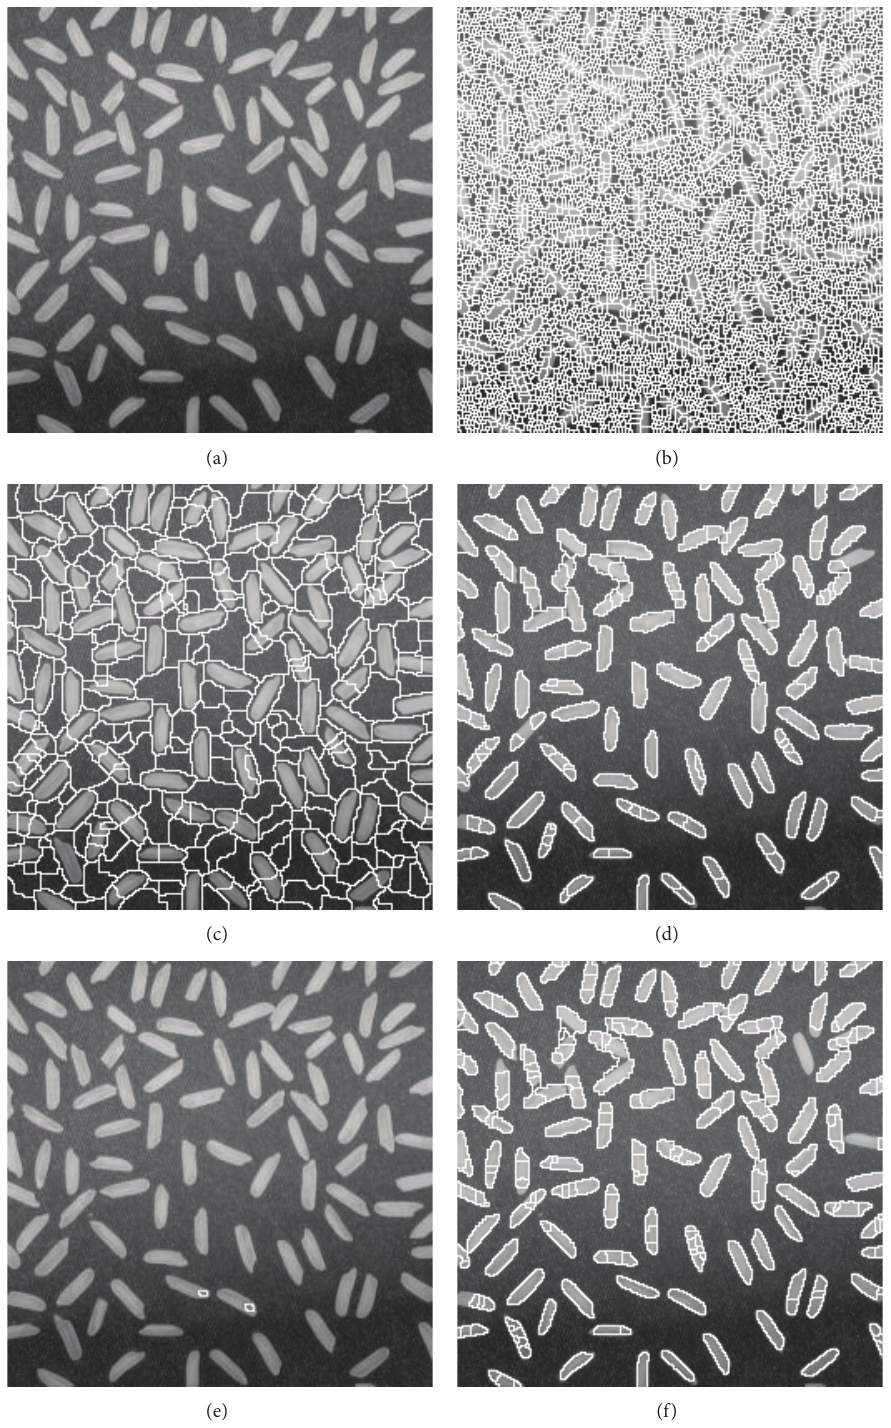
Figure 1: From left to right and from top to bottom: original image, result of traditional watershed algorithm, result of final multi-scale gradient algorithm, result of [4] algorithm, result of [15] algorithm, and result of the new